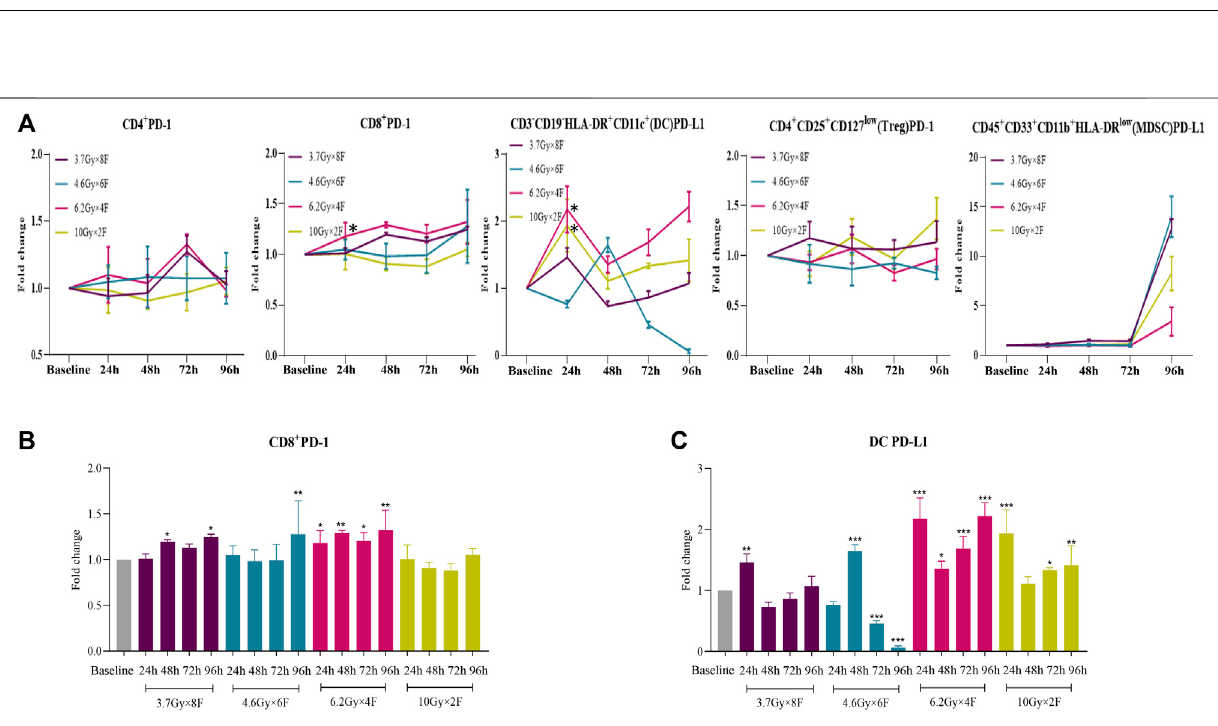
Frontiers in Molecular Biosciences |